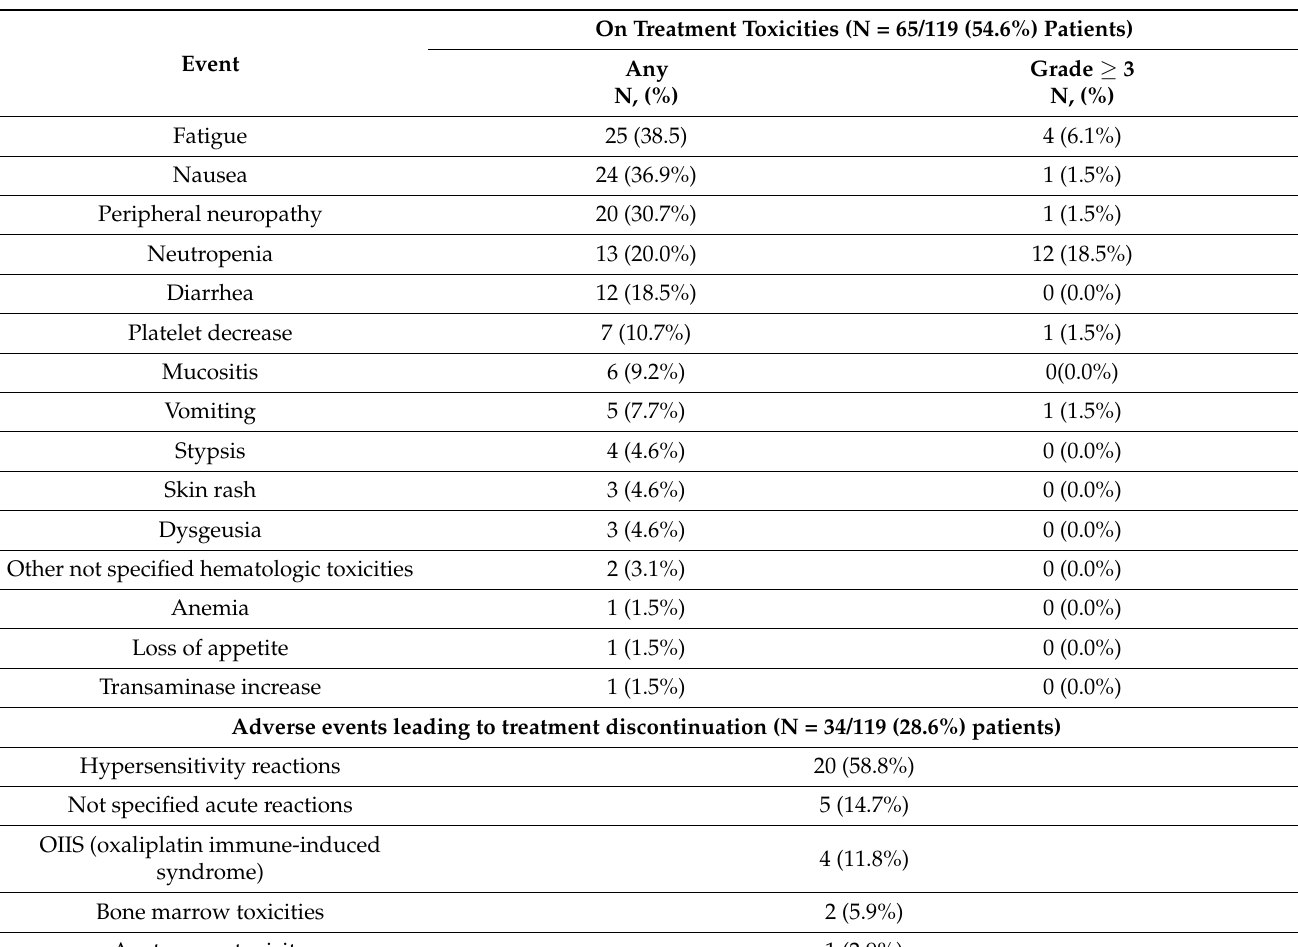
Table 3. Oxaliplatin retreatment adverse events, according to the Common Terminology Criteria for Adverse Events (CTCAE) retrieved in our retrospective patients’ charts review. Keys: * = both patients who experienced these adverse events were also receiving bevacizumab together with oxaliplatin and 5-fluorouracil; N = absolute number of